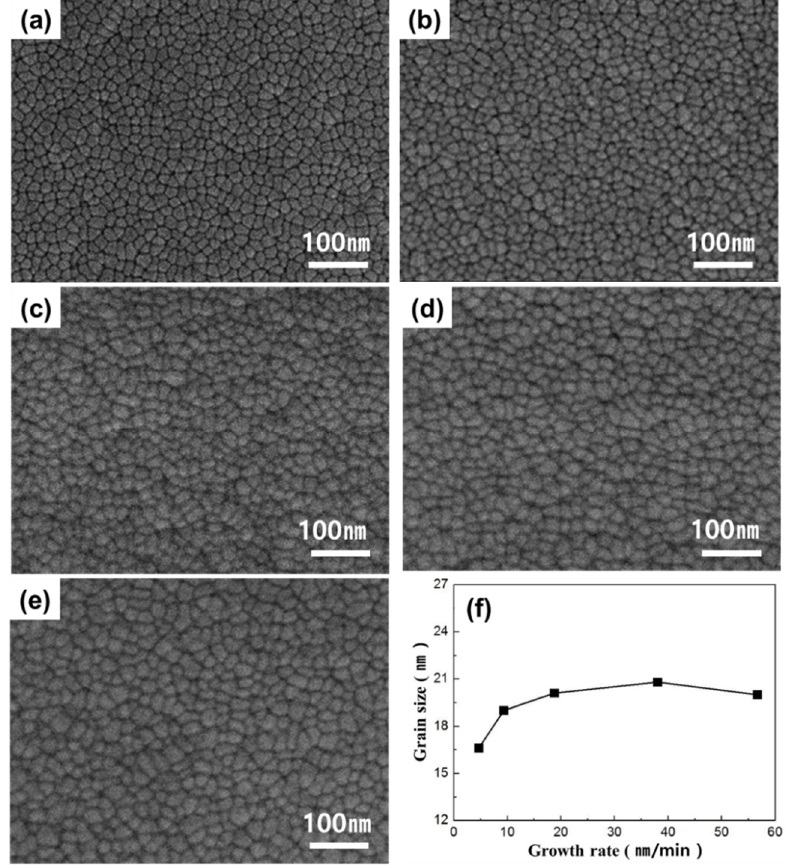
Figure 2. FE-SEM images of Ti-50.0 ± 0.3Ni (at %) thin film with growth rates of ( a ) 4.64 nm/min, ( b ) 9.33 nm/min, ( c ) 18.78 nm/min, ( d ) 38.00 nm/min, and ( e ) 56.67 nm/min; and ( f ) relationship between grain size and growth rate. (Deposition condition: thickness (1.69 ± 0.2 μm), substrate temperature (293 K)).